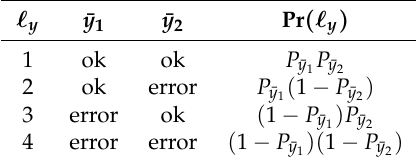
Table 1. Probability of each mode in (cid:96) y .